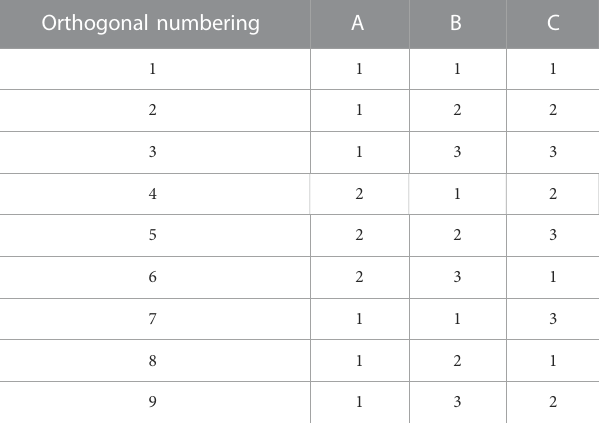
TABLE 1 Orthogonal design table of